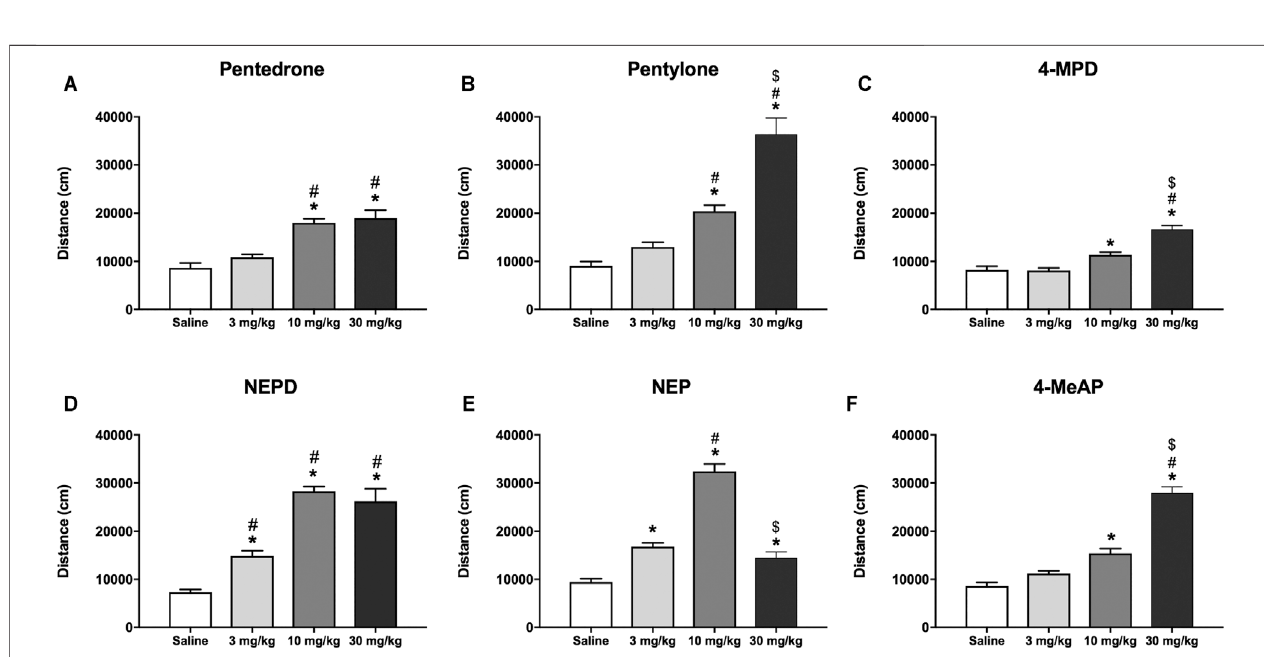
FIGURE4| Effectsofpentedrone (A) ,pentylone (B) ,4-MPD (C) ,NEPD (D) ,NEP (E) ,and4-MeAP (F) oncumulativeHLAinmice.Barsrepresent themean ± SEM of the total distance (cm) traveled in 60 min. Tukey ’ s multiple-comparisons test; * p < 0.05 vs the saline group; # p < 0.05 vs the 3 mg/kg dose group; $ p < 0.05 vs the 10 mg/kg dose group ( N (cid:2) 12 –